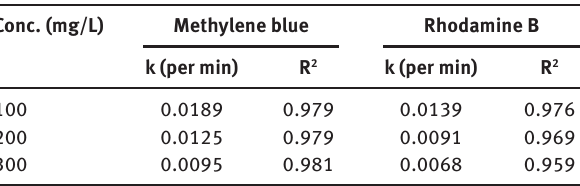
Table 2: Rate constants of Ag-TiO Methylene blue and Rhodamine B dye with various initial concentra- tions of